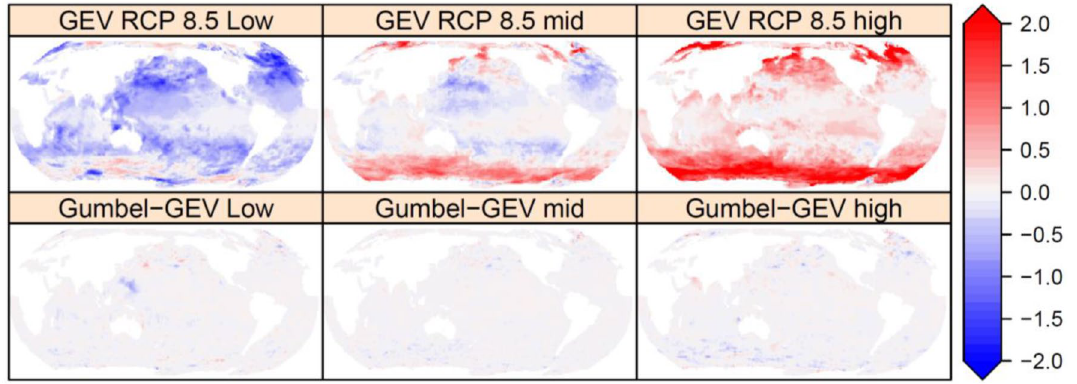
Figure 3. Estimated range of the incremental change in extreme wave height ( δ H m0,100 ) [m] for the RCP 8.5 simulations over a period of 100 years. Top row GEV RCP 8.5 and bottom row the difference between Gumbel and GEV RCP 8.5. See "Methods" section for definition of estimated ranges: low, mid and high. Created using the R statistical software version 4.0.2 22